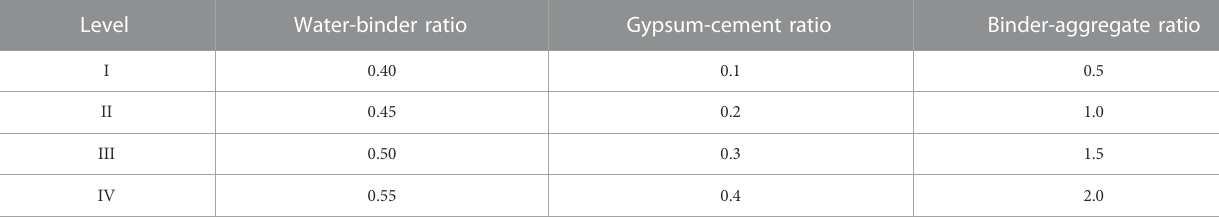
TABLE 1 Horizontal setting of orthogonal test factors for class 1 sandstone materials.